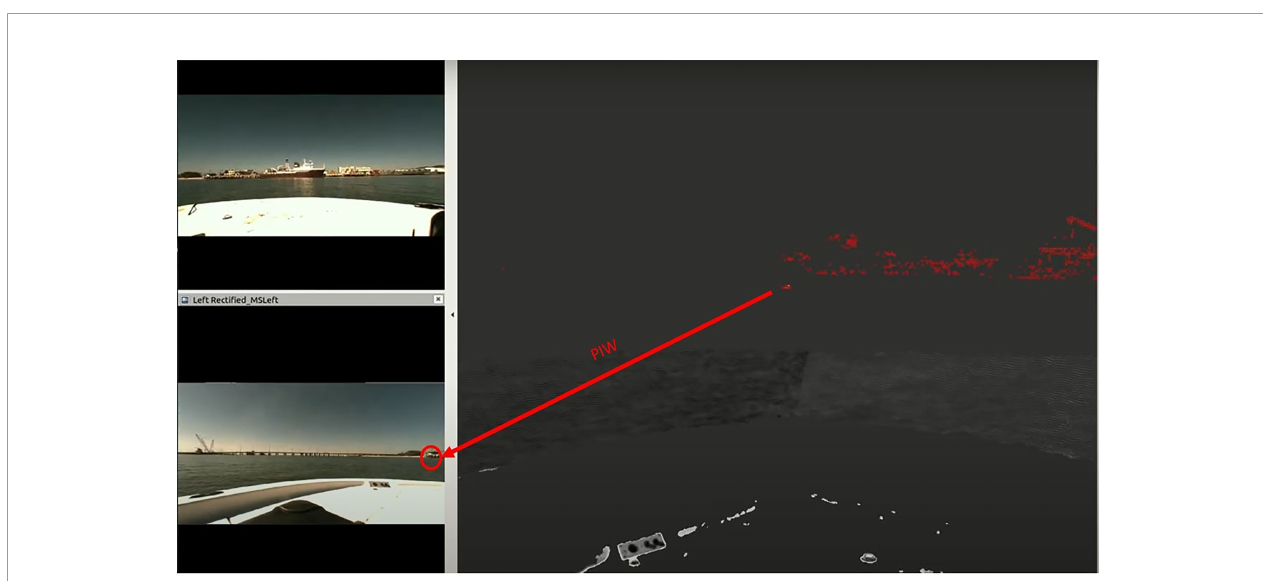
FIGURE 5 | [Top Left] Image from the left stereoscopic camera MS1, [Lower Left] Image from the right stereoscopic camera, MS2, [Right] Output from the LiDAR bag fi